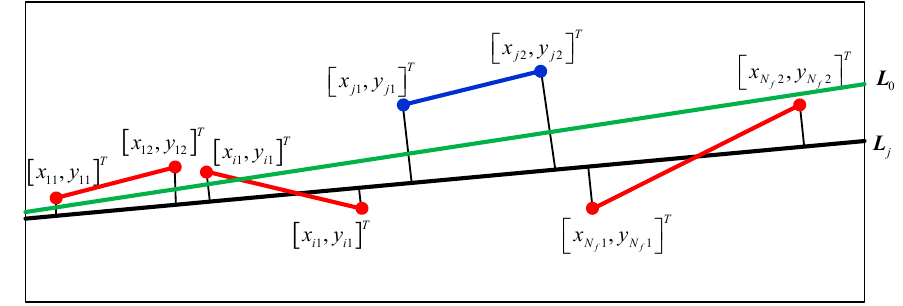
Figure 7. RANSAC-based line segment stitching method. L 0 is the line fitting results using all line segment candidates and L j is the RANSAC-based line